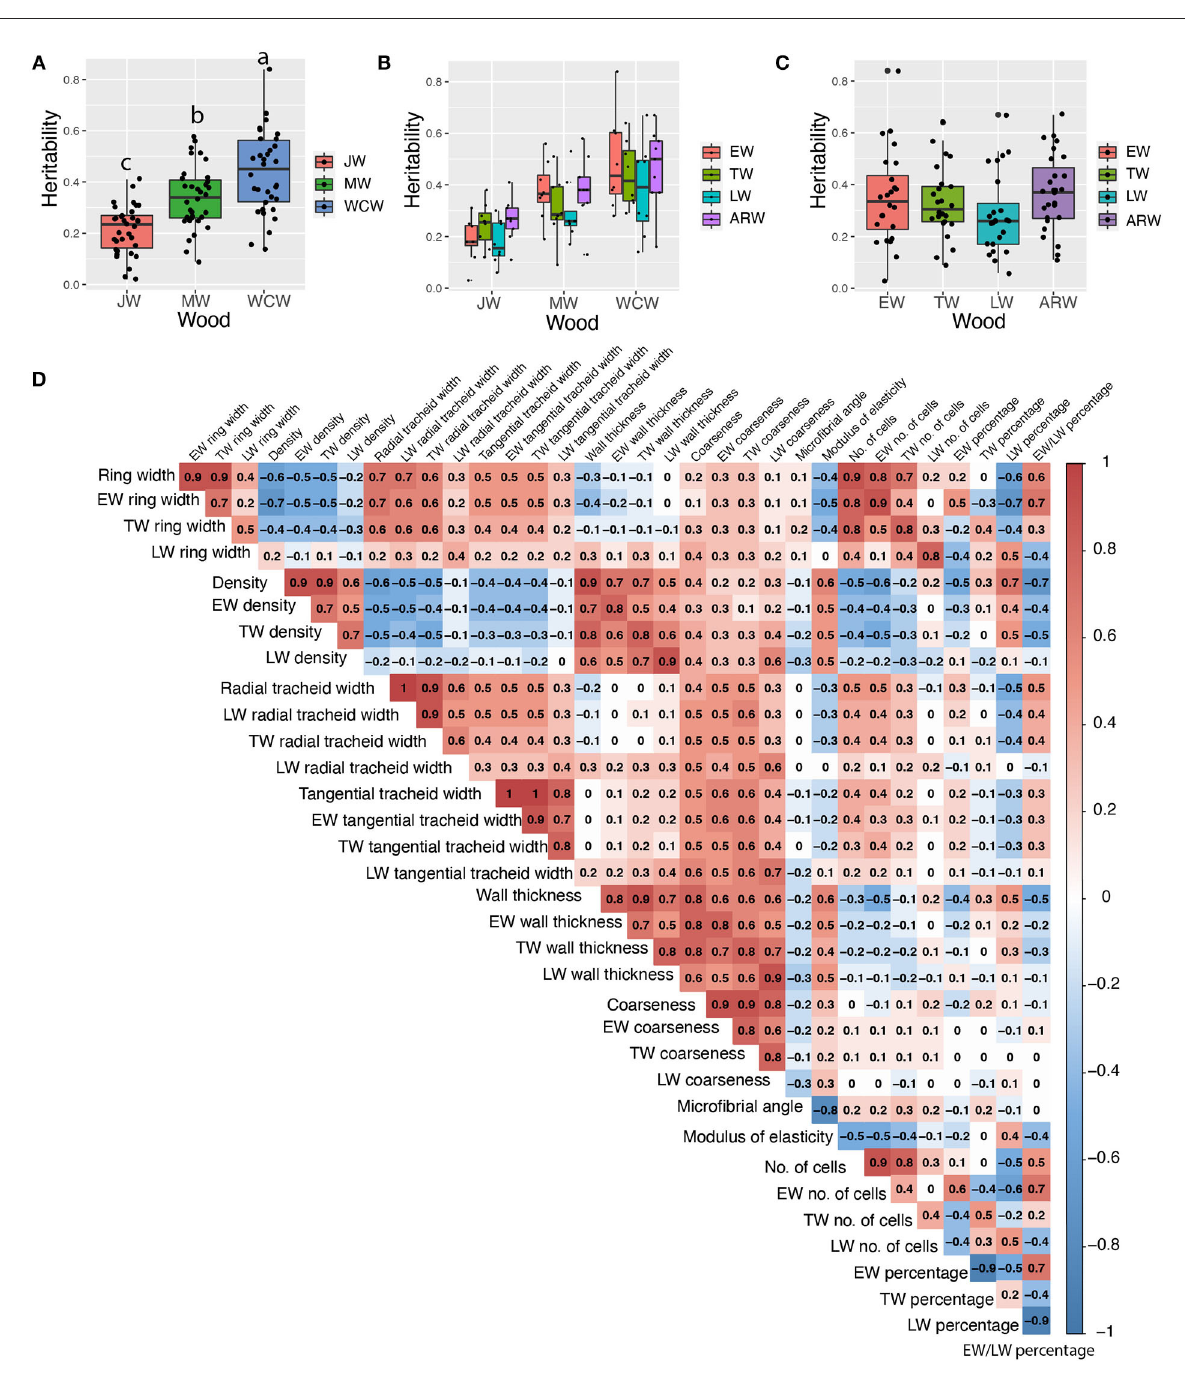
FIGURE3 Estimated narrow-sense heritabilities of growth and wood quality traits and pairwise Pearson phenotypic correlations among all wood traits from the whole core wood (WCW). (A) Boxplots of pedigree-based narrow-sense heritabilities of 34 traits from juvenile (JW), mature (MW), and WCW using 505 half-sib families. (B) Boxplots of pedigree-based heritabilities of 34 traits from earlywood (EW), transition wood (TW), latewood (LW), and annual ring wood (ARW) using 505 half-sib families. (C) Boxplots of pedigree-based heritabilities for growth and wood quality traits produced at different seasons in JW, MW, and WCW using 505 half-sib families. (D) Pairwise Pearson phenotypic correlations among all wood traits from the whole core wood (WCW). The color spectrum indicates highly positive (red) to highly negative (blue) correlations, and the number indicates the correlation values. The blank indicates a lack of significant correlation ( P > 0.01). In (A) , the different letters between mean heritabilities in JW, MW, and WCW represent significant differences ( P >